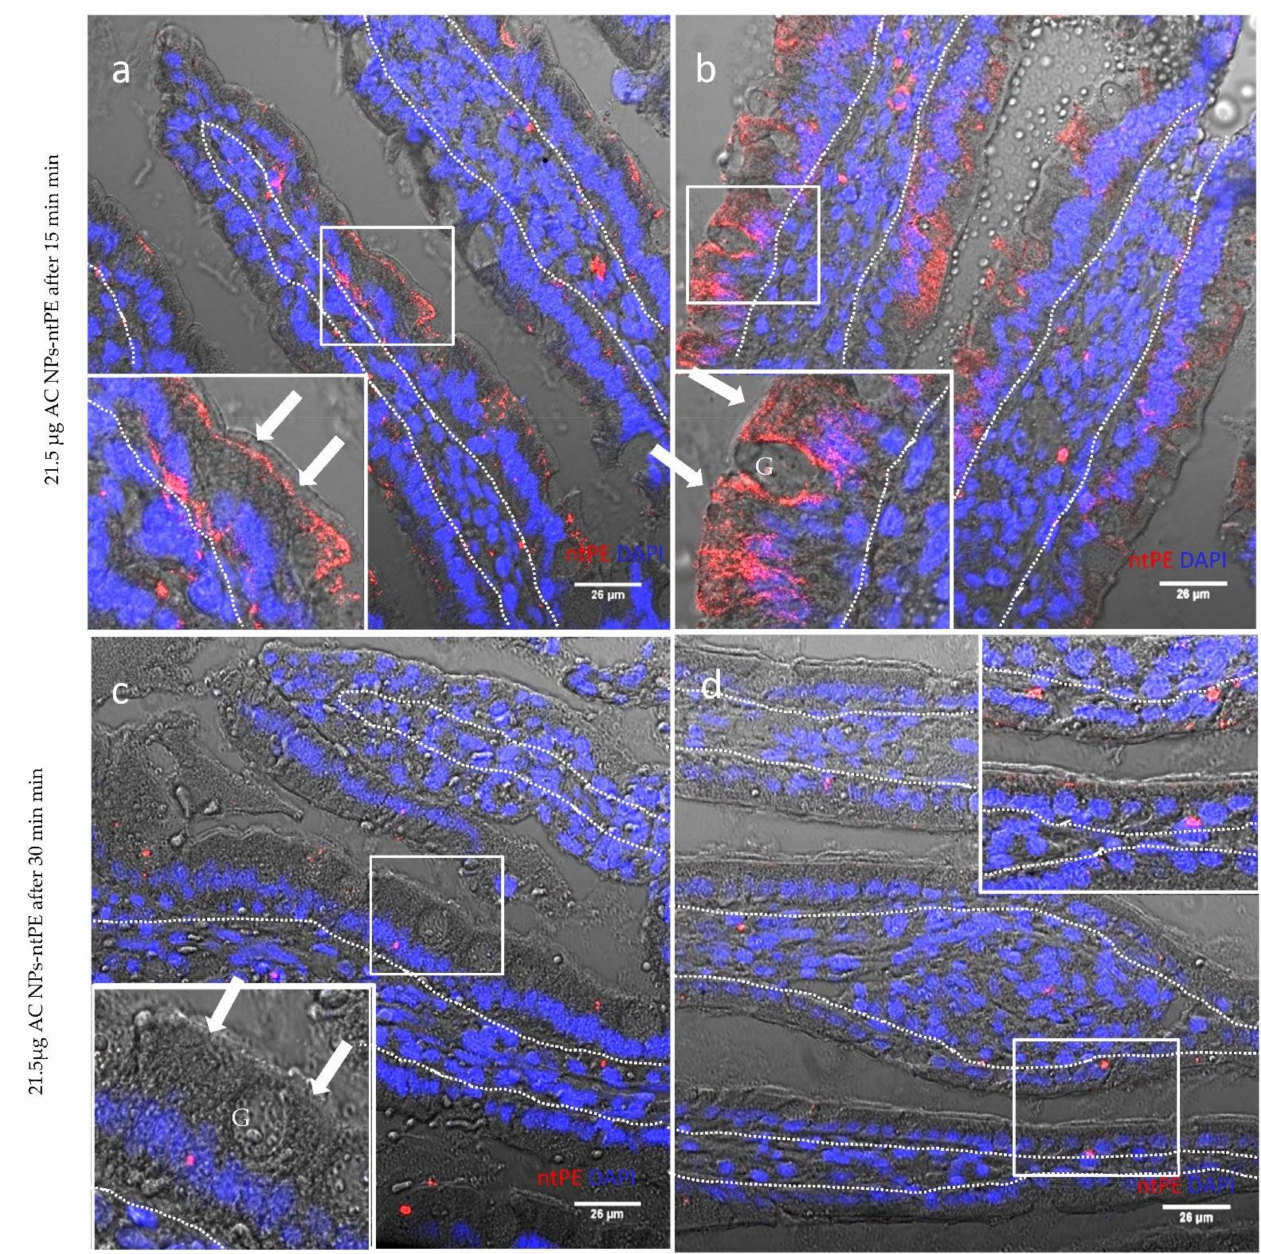
Figure 7. Representative confocal fluorescence images of intestinal villi following intra-luminal injection (ILI) into rat jejunum of test articles. Alginate/chitosan nanoparticles AC NPs were coupled to a non-toxic version of Pseudomonas aeruginosa exotoxin A (ntPE) that had been labeled with red fluorescent dye Alexa Fluor ®® 546 (AC NPs-ntPE*). Tissue distribition of AC NPs-ntPE* after 15 min post-ILI ( a , b ) and after 30 min post-ILI ( c , d ). Apical surface of enterocytes = arrow. Mucin-filled goblet cell = G. Lamina propria-epithelium demarcation = dashed line. Nuclei were stained blue with DAPI. Scale bar = 26 µ